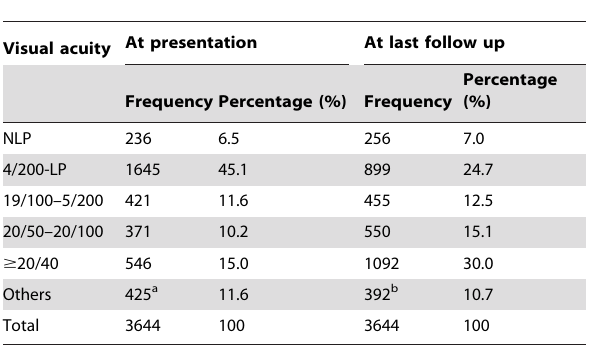
Table 4. A comparison of final visual acuity and presenting visual